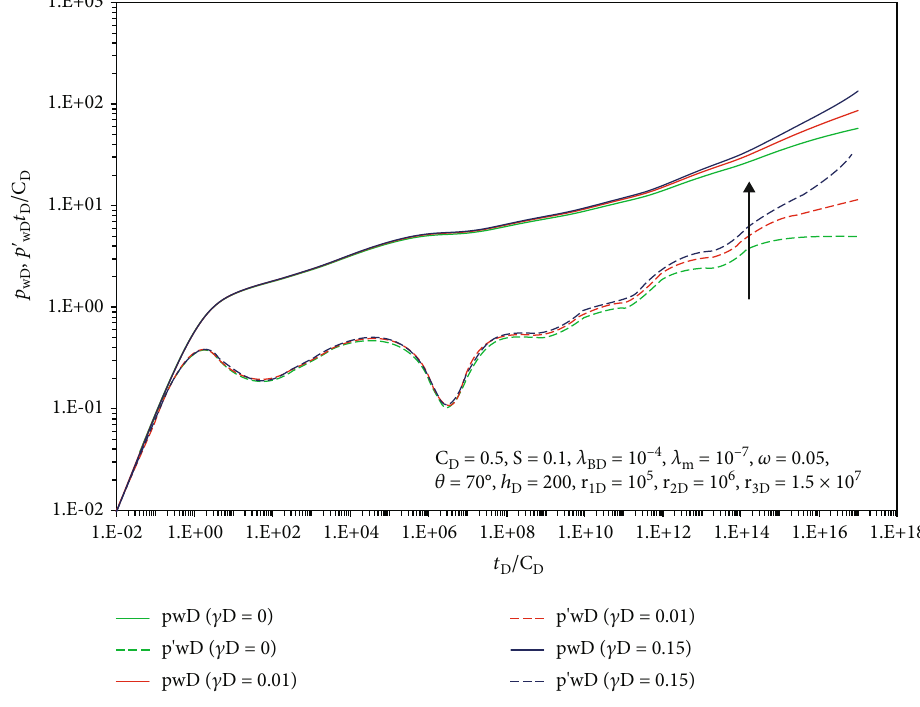
Figure 6: In fl uence of permeability modulus on pressure dynamic curve.